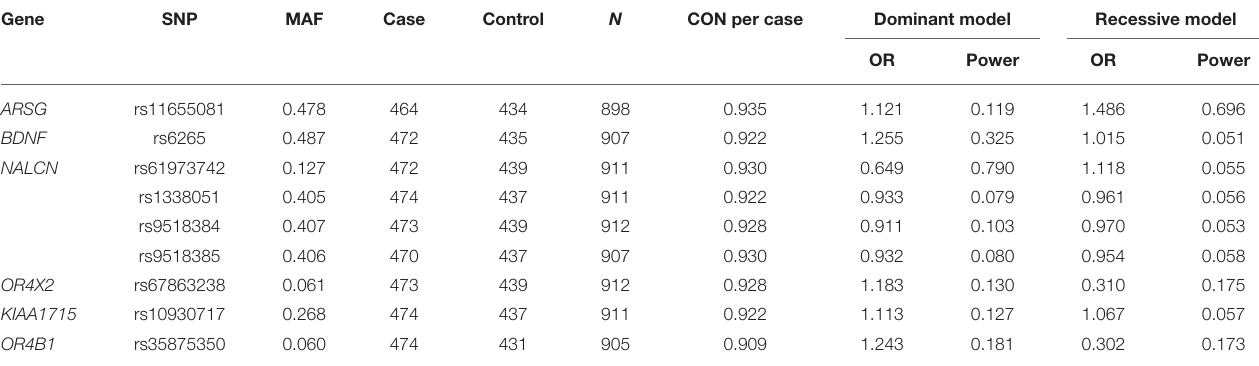
TABLE 4 | The power of dominant and recessive models. Gene SNP MAF Case Control N CON per case Dominant model Recessive model